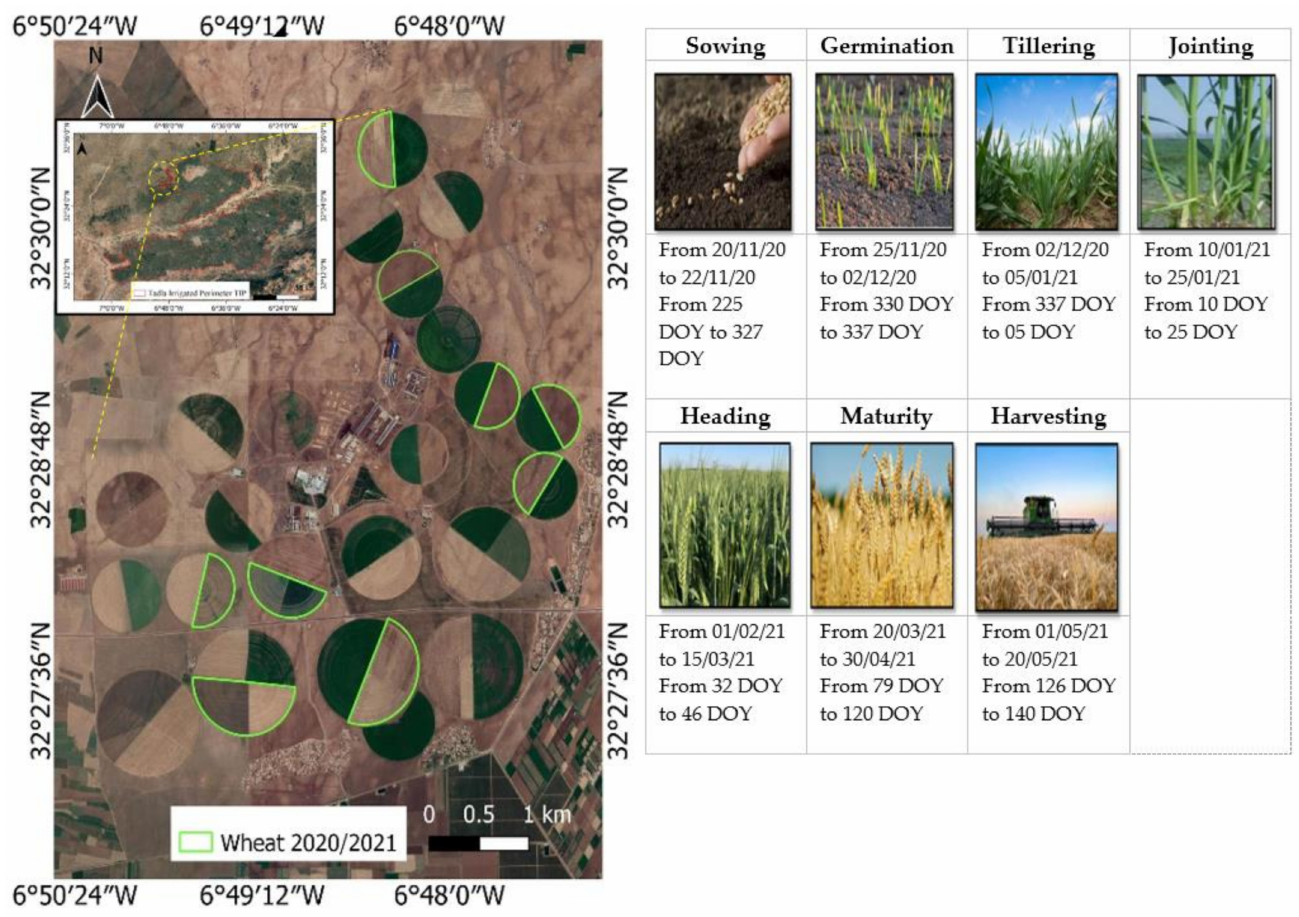
Figure 2. Location of wheat fields for the growing season 2020/2021 ( left ) and calendar of the phenological stages of wheat ( right